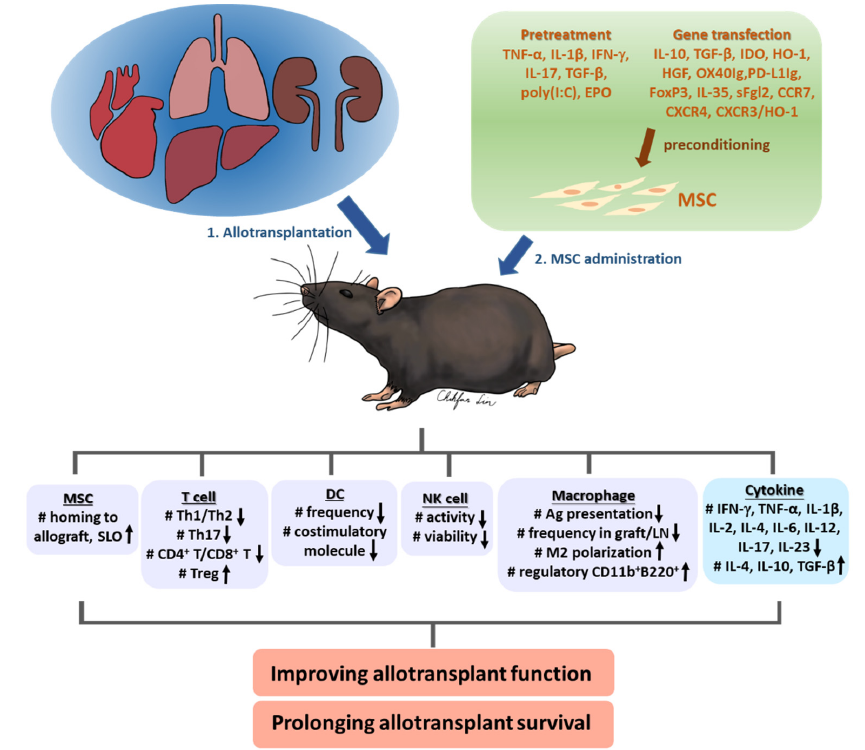
Figure 2. Summary of in vivo effects of preconditioned MSCs applied in allotransplantation. Table 2. Preconditioned MSCs applied in organ/tissue allotransplantation, grouped by transplant